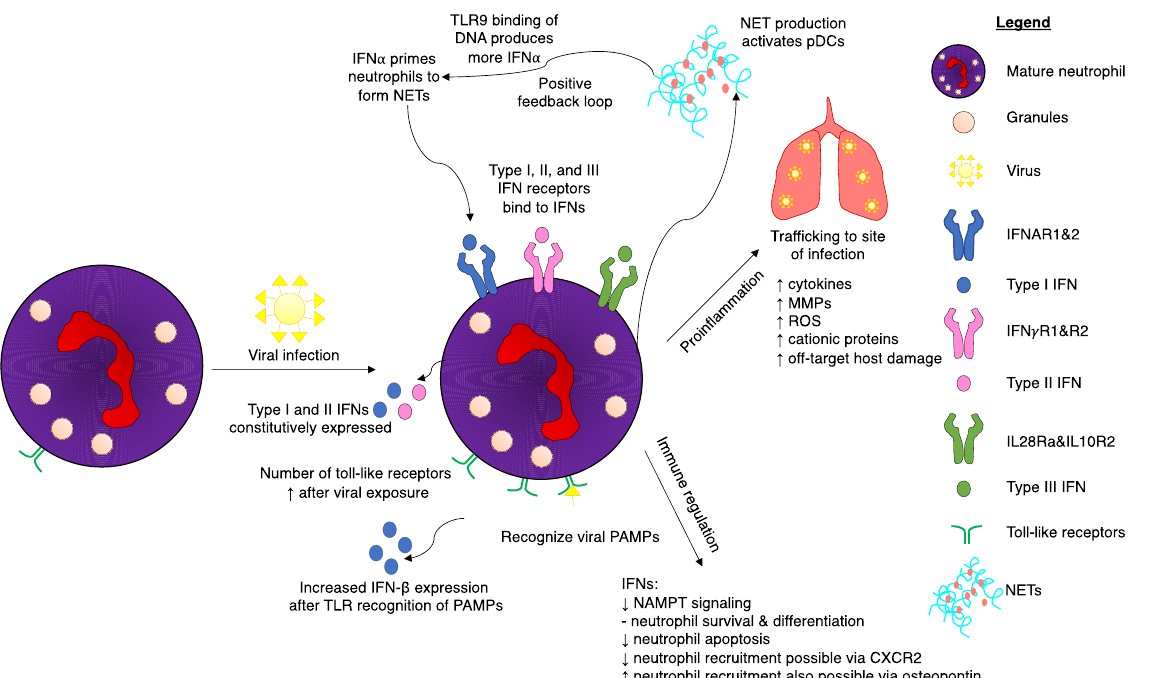
Figure 3. Interferon (IFN)-mediated regulation of neutrophils upon viral infection of a host. Viral infections induce many changes to neutrophil biology. Toll-like receptor (TLR) expression increases after viral exposure, resulting in increased production of type I interferons (IFNs). Neutrophils possess receptors for all three interferon subsets. A positive feedback loop occurs during the production of neutrophil extracellular traps (NETs). IFN α results in NET production, which in turn activates plasmacytoid dendritic cells (pDCs). Binding of deoxyribonucleic acid (DNA) from the NETs to TLR9 produces more IFN α , which, in turn, can result in excessive NET production. IFN pathways result in both a proinflammatory response and immunoregulation. Although neutrophils are integral for hosts to successfully eliminate viral infections, certain viruses have adapted mechanisms to hijack the IFN response to cause unwanted neutrophil-induced host damage. Excessive production of cytokines can lead to fatal immune-mediated overreactions to the viral threat. Other abbreviations: CXCR2: CXC chemokine receptor 2, MMP: matrix metalloproteases, NAMPT: nicotinamide phosphoribosyltransferase, ROS: reactive oxygen species.